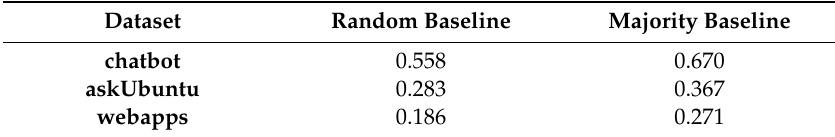
Table 4. Calculated random and majority baselines for di ff erent datasets.